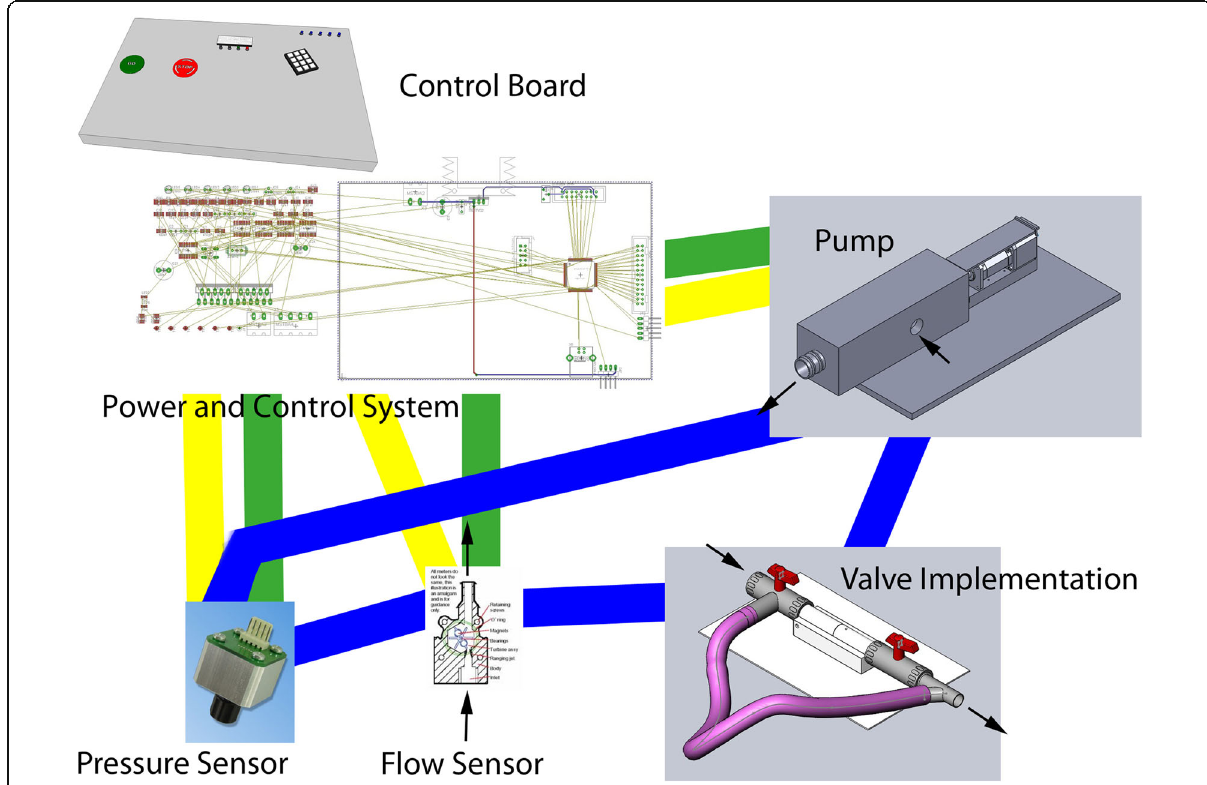
Fig. 6 Sample schematic setup of an experimental environment to test valves. The 3D printed valve would be included in the valve implementation part inside the flow loop (blue